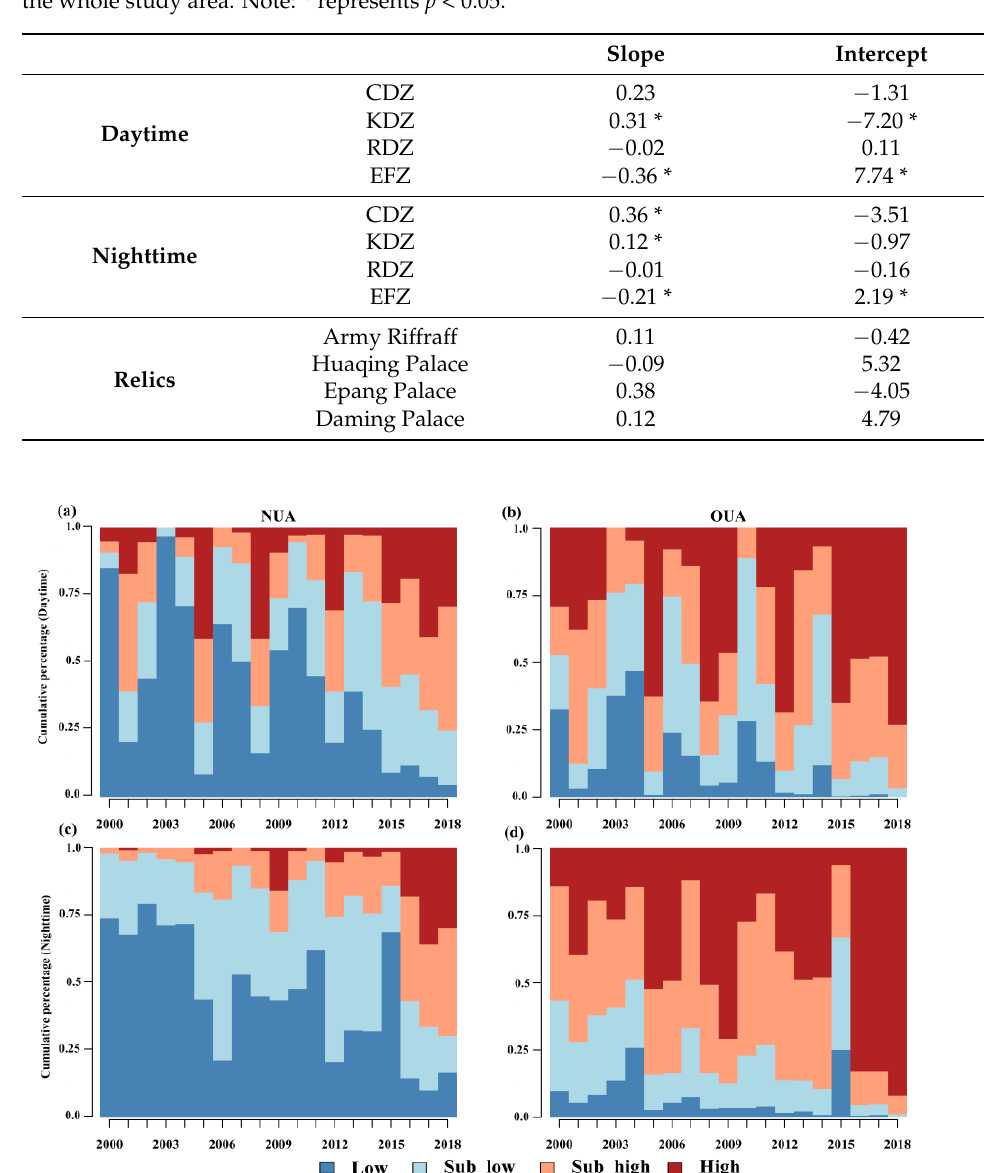
Figure A1. Annual changes in cumulative percentages of daytime SUHI in old and new urban areas ( a , b ) and nighttime SUHI in old and new urban areas ( c , d ) from 2000 to 2018.